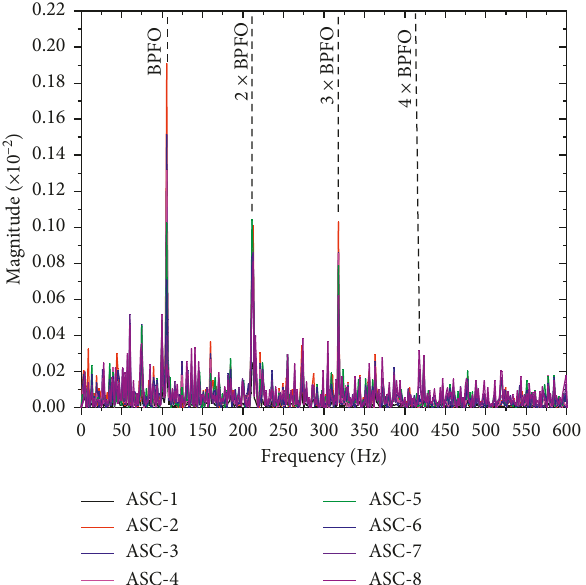
Figure 5: Squared envelope spectrums of partial ASCs.